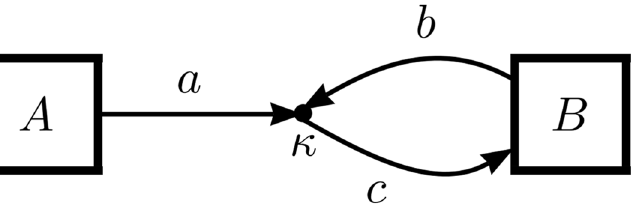
Fig 4. OFFL diagram for the most general two-species consumer-resource